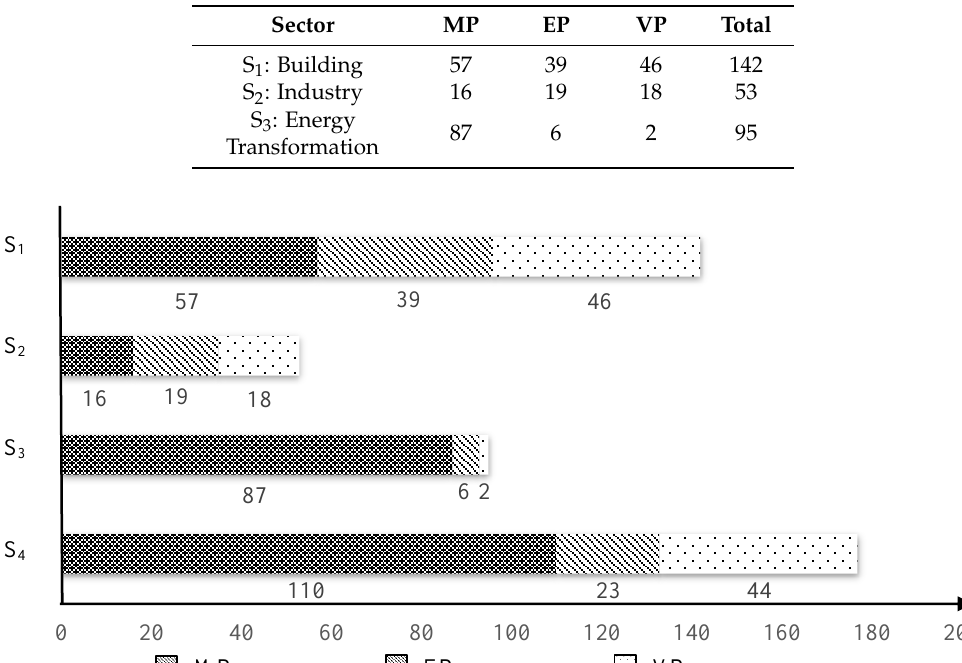
Figure 6. The number of the three kinds of carbon reduction policies adopted in four emission